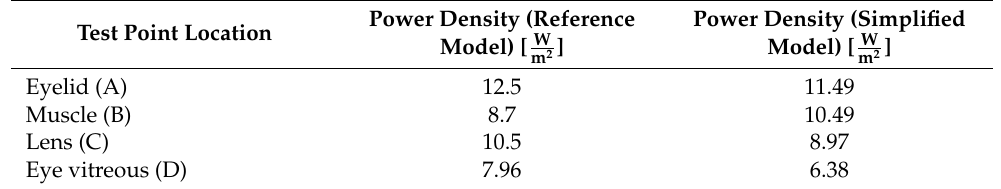
Table 3. The material properties of the simplified model of the face: initial values and final values.